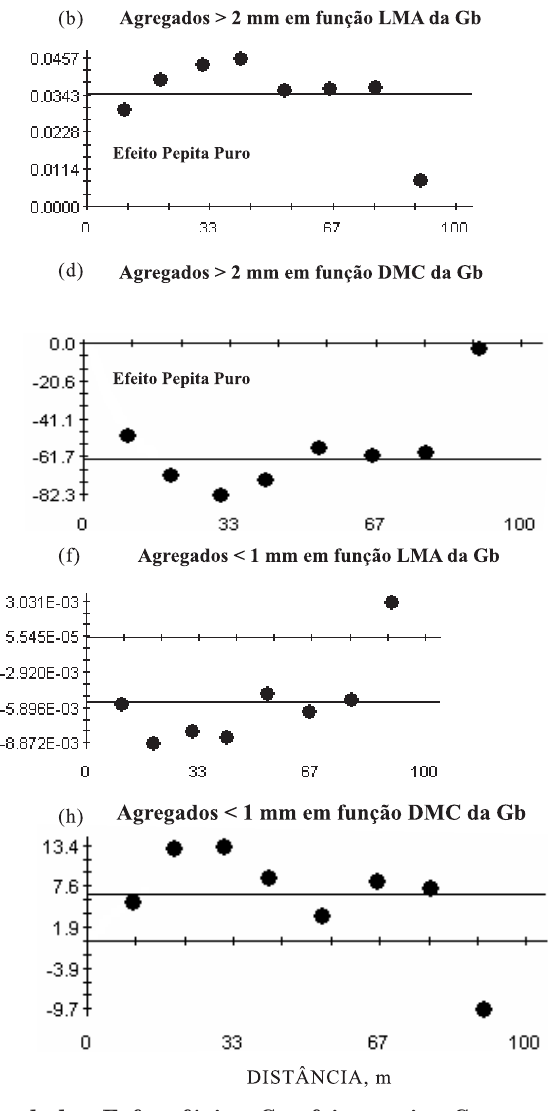
Figura 5. Semivariogramas cruzados dos atributos estudados. Esf.: esférico; C a: alcance (m); R 2 : coeficiente de